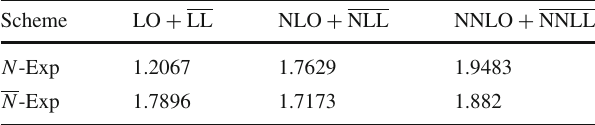
Table 14 The K-factor values for resummed result for N and N expo- nentiation at central scale μ R = μ F = m H / 2 for 13 TeV LHC Scheme LO +